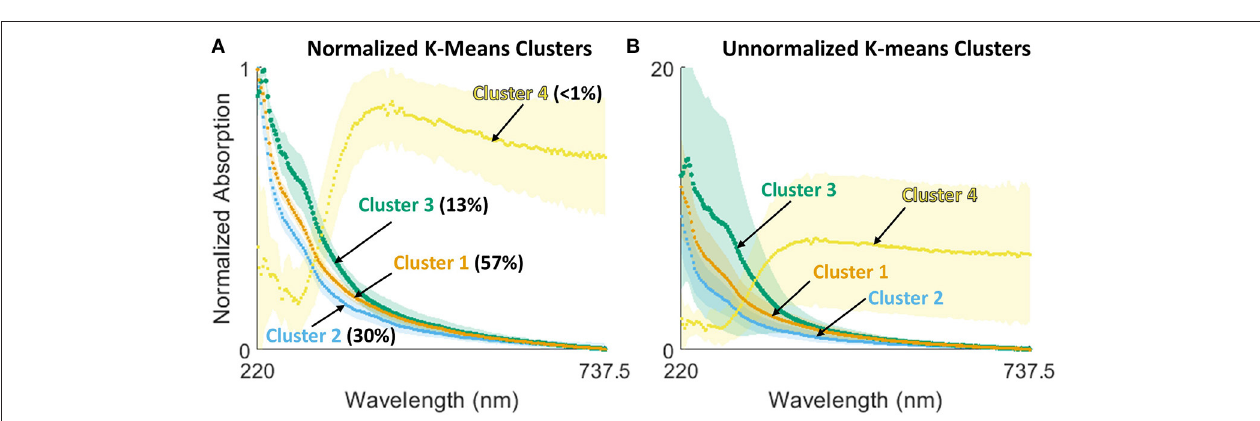
FIGURE 2 | K-means cluster spectra mean and standard deviation as (A) normalized measurements (labeled with percentage of measurements within that cluster) and (B) unnormalized